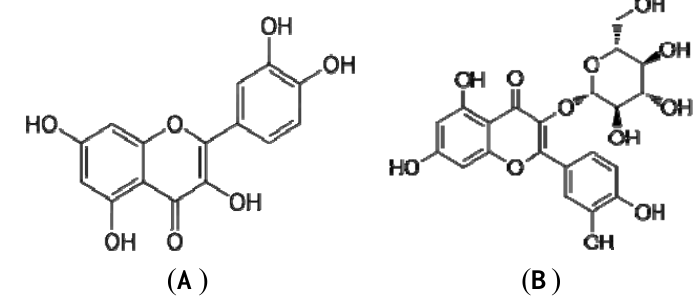
Figure 2. The predominant flavonoids—( A ) quercetin and ( B ) isoquercetin in Chinese hawthorn